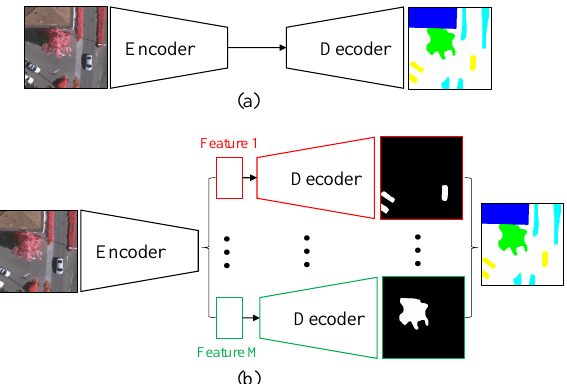
Figure 1. Comparison between the traditional and the proposed segmentation networks. ( a ) The traditional segmentation network is comprised of an encoder that extracts features from input images and a decoder that restores the resolution of feature maps. ( b ) C-FCN shares the encoder to obtain general features while saving parameters and provides separate paths for every category to decode and classify every pixel based on their own specific